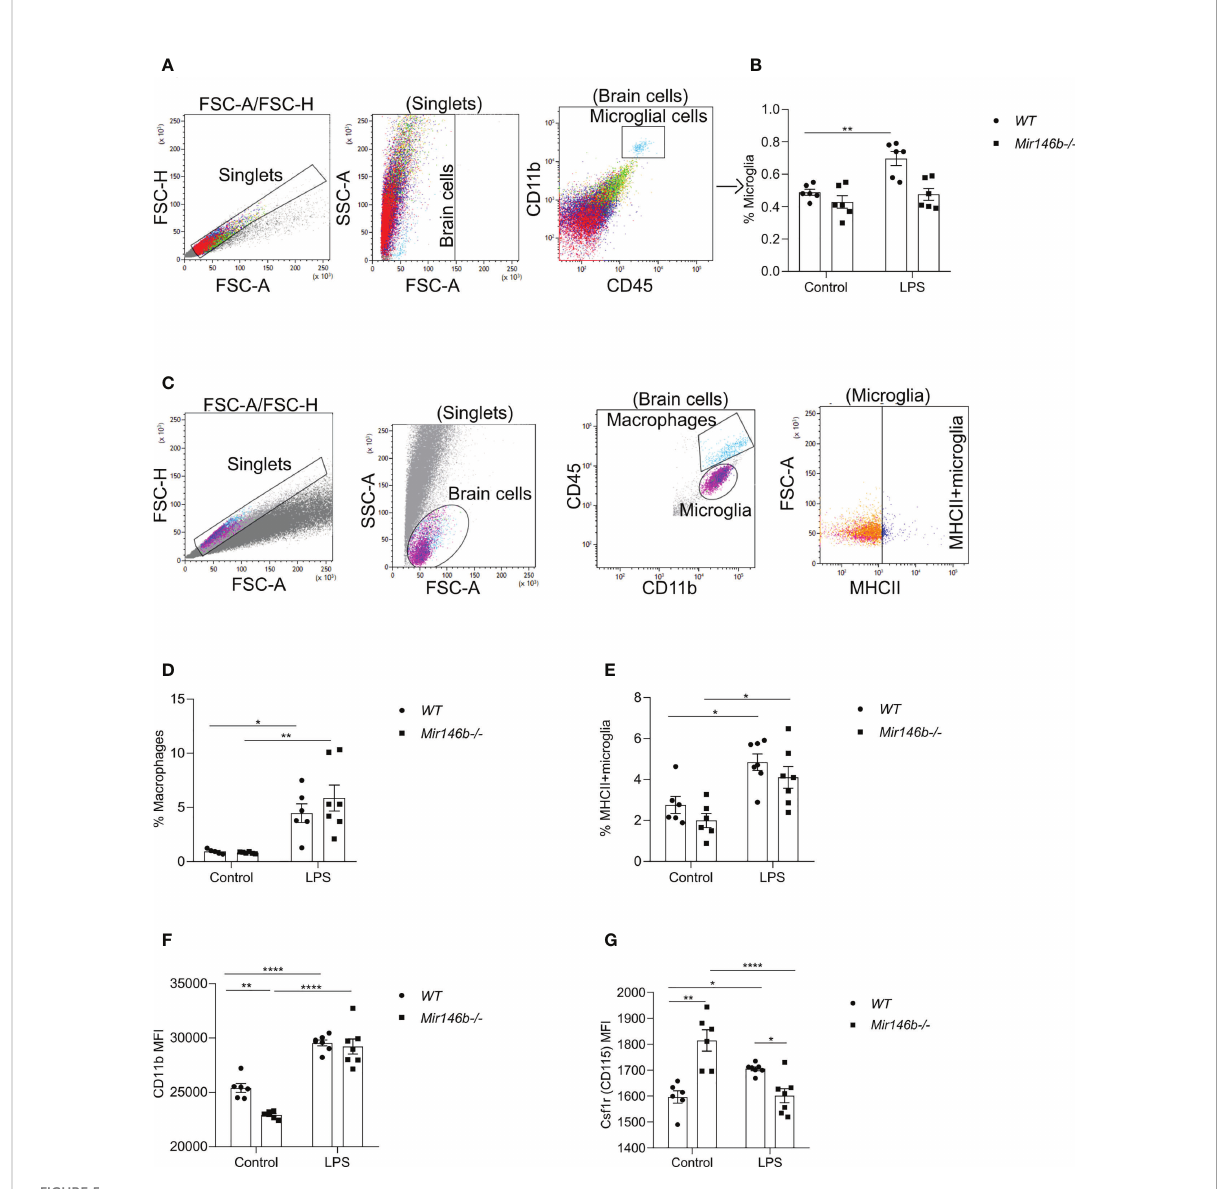
FIGURE 5 LPS-induced hippocampal microglial changes in WT and miR-146b de fi cient mice. Flow cytometry analysis with indicated markers was performed using brain cells from mice were injected with LPS in saline or equal volume of saline (control). (A) Representative gating strategy for quanti fi cation of microglial percentage. (B) Percentage of microglial cells among total brain cells. (C) Representative gating strategy for quanti fi cation of macrophages and MHCII+ microglia. (D) Percentage of macrophages (E) Percentage of MHCII+ microglia among microglial cells. (F, G) Mean fl uorescent intensity (MFI) of CD11b and Csf1r (CD115) among microglial cells. Number of animals = 6-7. Data are represented as mean ± SEM; * p < 0.05, ** p < 0.01, **** p < 0.0001 (Two-way ANOVA with Tukey ’ s multiple comparison